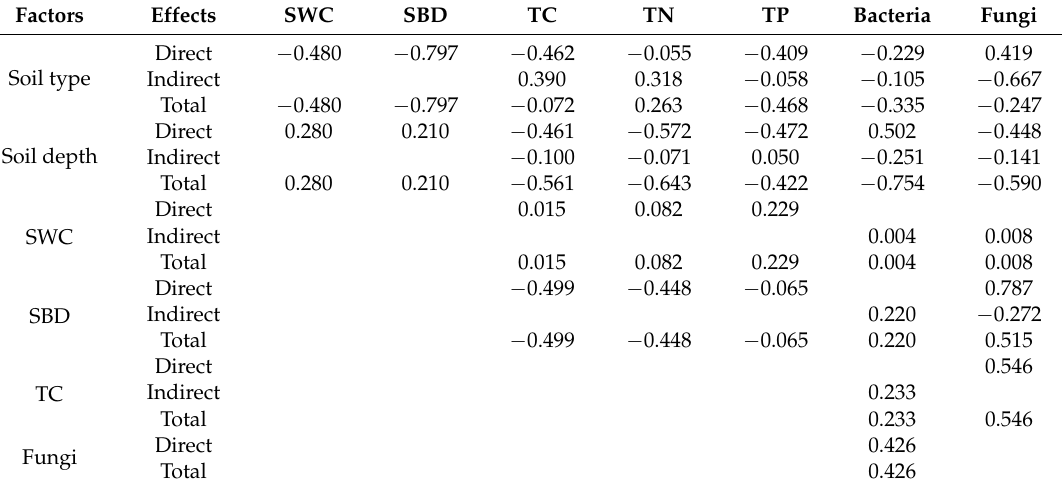
Table 4. Standardized direct, indirect and total effects on total soil C, N, P contents and soil microbial